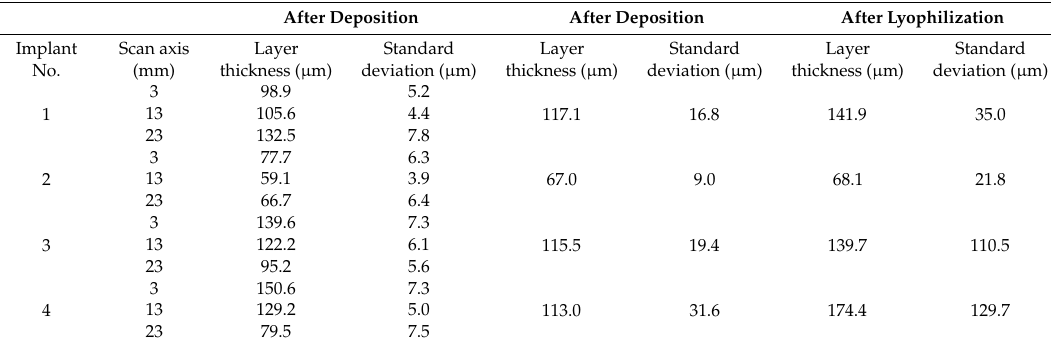
Table 1. Thicknesses of the deposited layers measured at three di ff erent levels along the height of the coated implants; average values for each sample after layer deposition and after lyophilization. The data is also shown in a graph included in Figure 4. After Deposition After Deposition After Lyophilization Implant